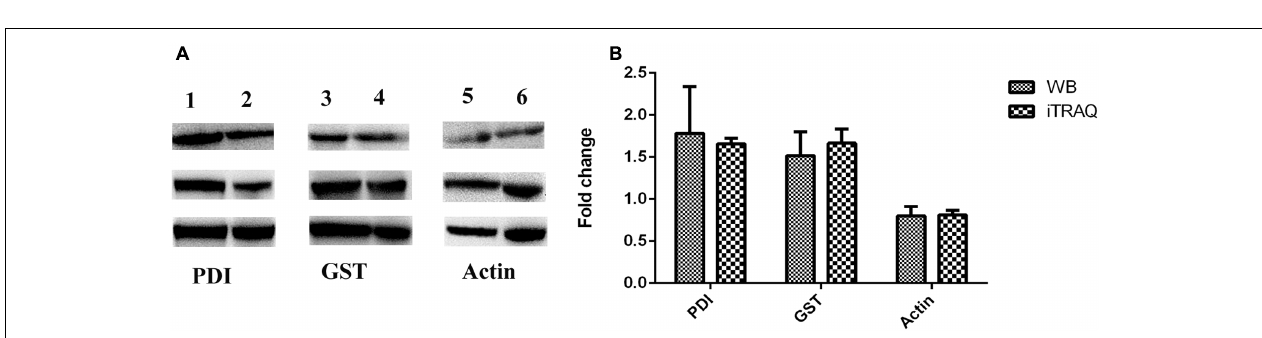
FIGURE 5 | The PPI networks of all DEPs. The PPI networks were built using STRING version 10.0 with a high combined score > 700. The node color indicates downregulated proteins (red) and upregulated proteins (green).